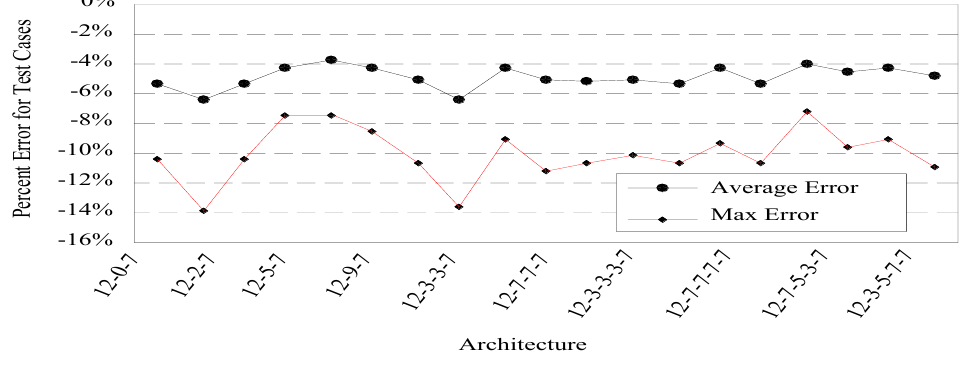
Fig. (4) Neural Network Architectures vs.